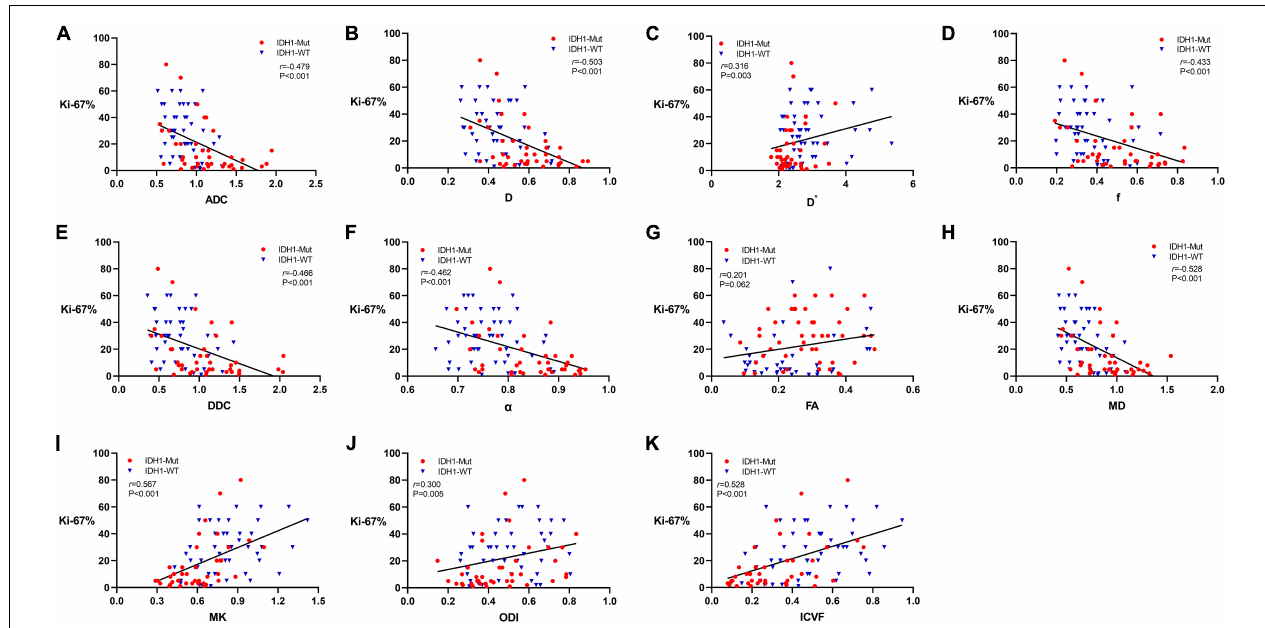
FIGURE 4 | Scatter diagrams demonstrating the correlations between Ki-67 labeling index and parameters of DWI (A) , IVIM (B–D) , stretched-exponential DWI (E,F) , DTI (G,H) , DKI (I) , and NODDI (J,K) . And r represents the Spearman correlation